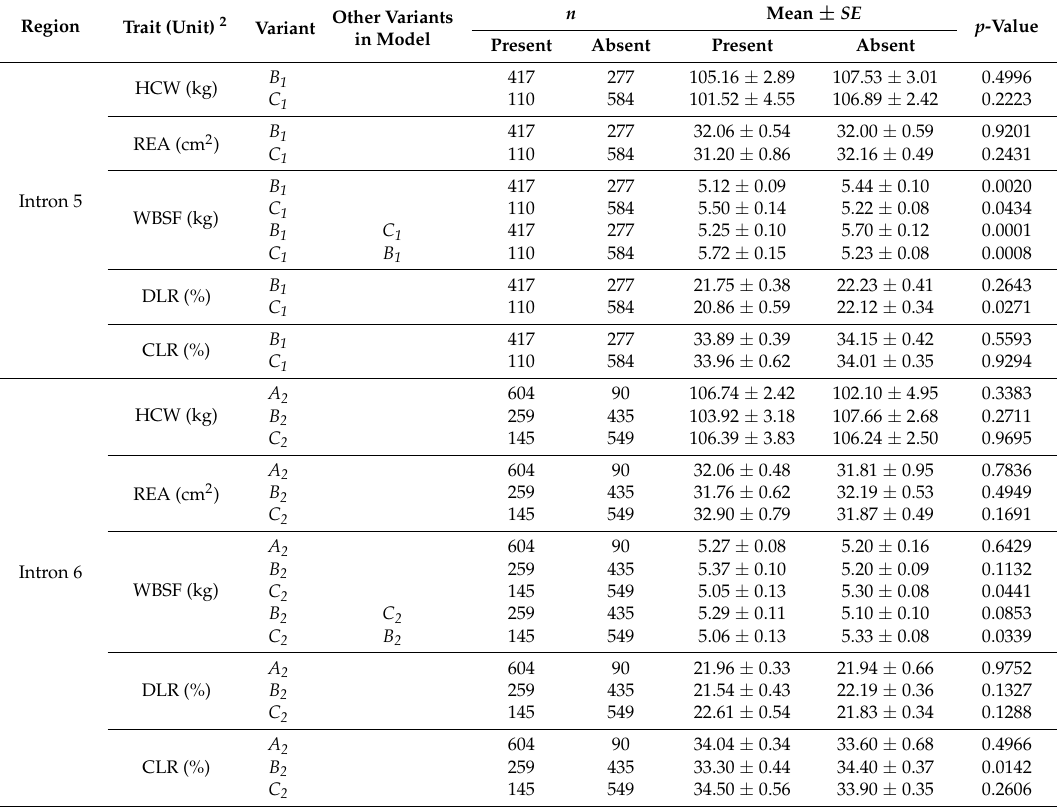
Table 3. Association of DGAT2 variants with carcass and meat quality traits (mean ± SE ) 1 in yaks. Region